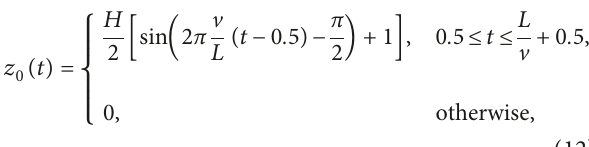
1A; (e) high velocity without intensity; (f) high (cid:31)